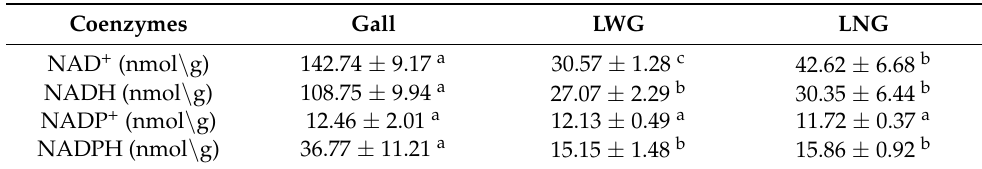
Table 1. The content of coenzymes in the different samples. Coenzymes